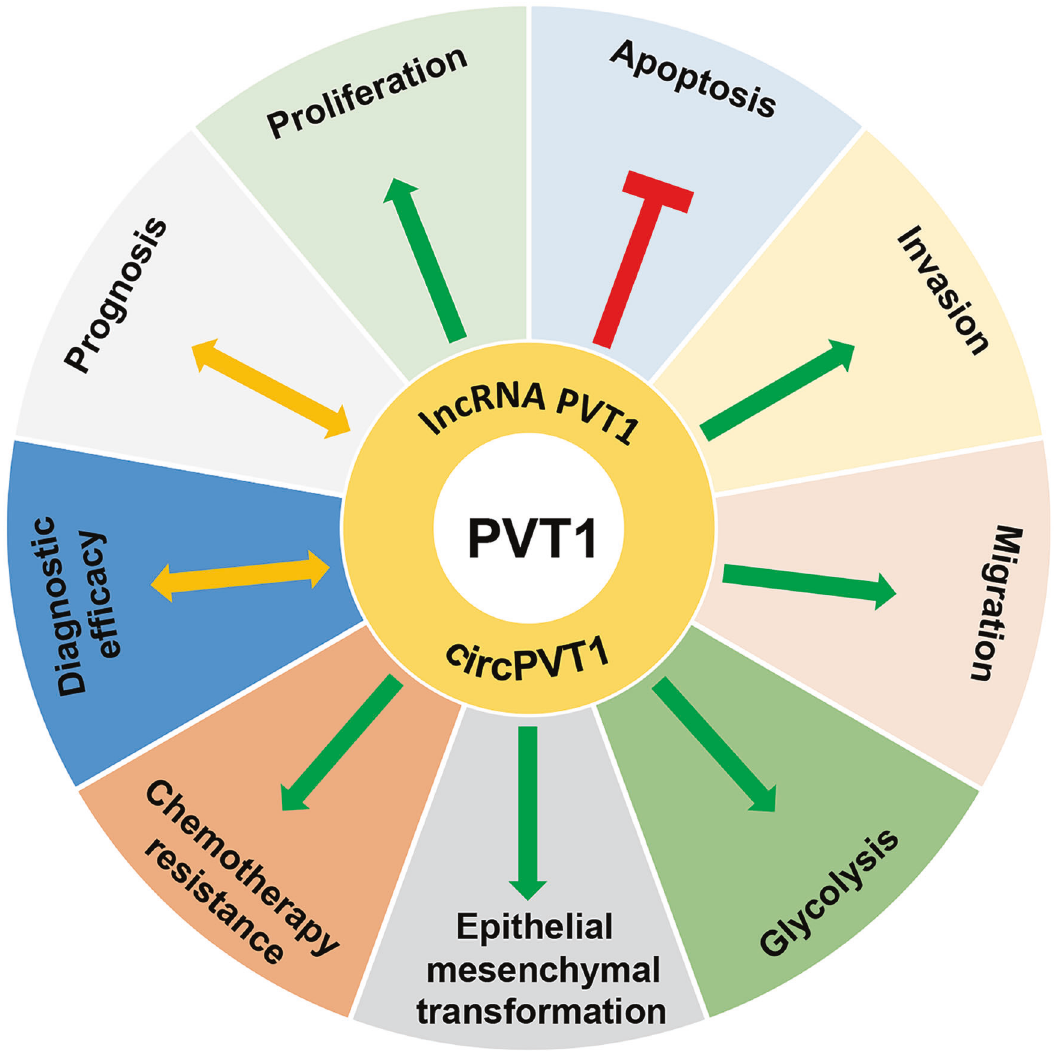
Fig. 3 The role of lncRNA PVT1 and circPVT1 in the progression of osteosarcoma. Green connections indicate promotion, red connections indicate suppression, and yellow connections indicate the presence of